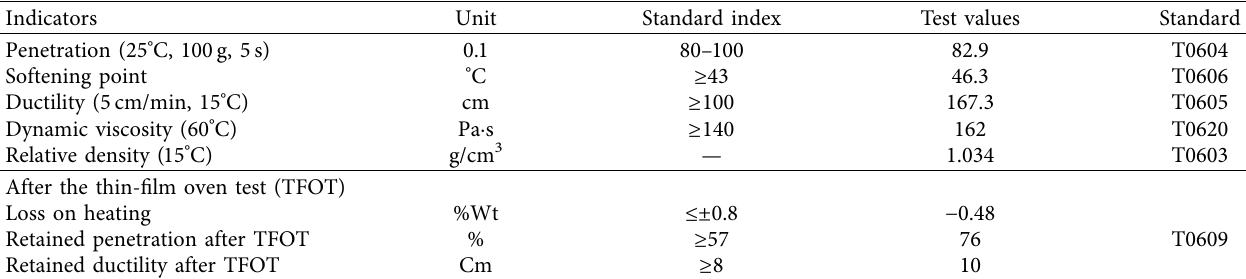
Table 2: Technical indexes of pen # 90 asphalt binder.